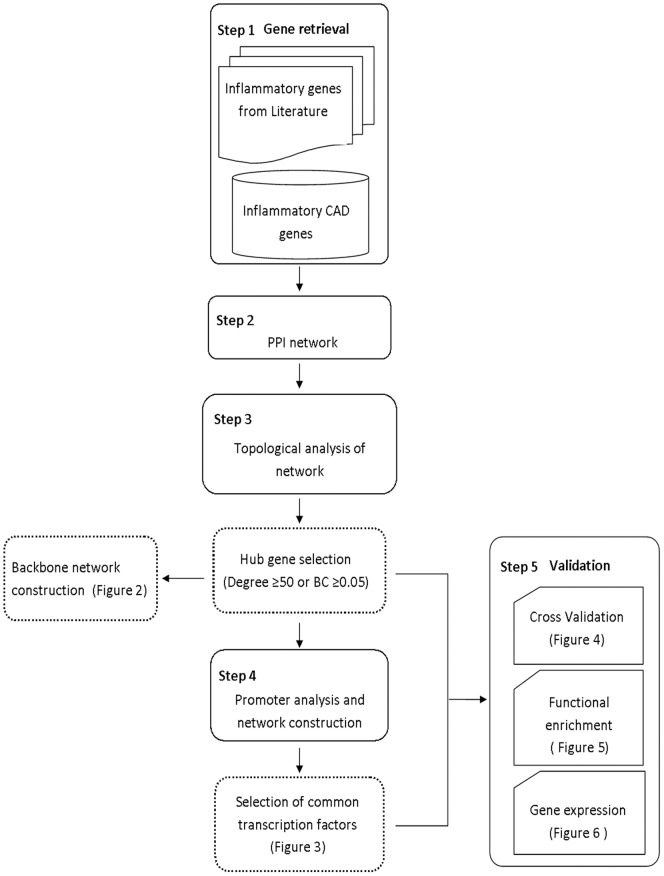
An overview of the work flow.An overview of the work flow has been summarized and consists of the following steps- Step 1: Retrieval of inflammatory genes from literature using PolySearch text mining tool and from CADgene database; Step 2: Analysis of protein interactions using STRING database; Step 3: Topological analysis of network using Cytoscape v2.8, based on betweenness centrality and node degree, leading to the identification of hub genes and construction of the backbone network; Step 4: Construction of a regulatory network for the hub genes and identification of common transcription factors (TFs) regulating them; Step 5: Validation of the hub genes based on cross-validation (1 to 4 node deletion), functional enrichment analysis (ClueGo) and quantitative evaluation of key genes and their common transcription factors by real-time PCR.